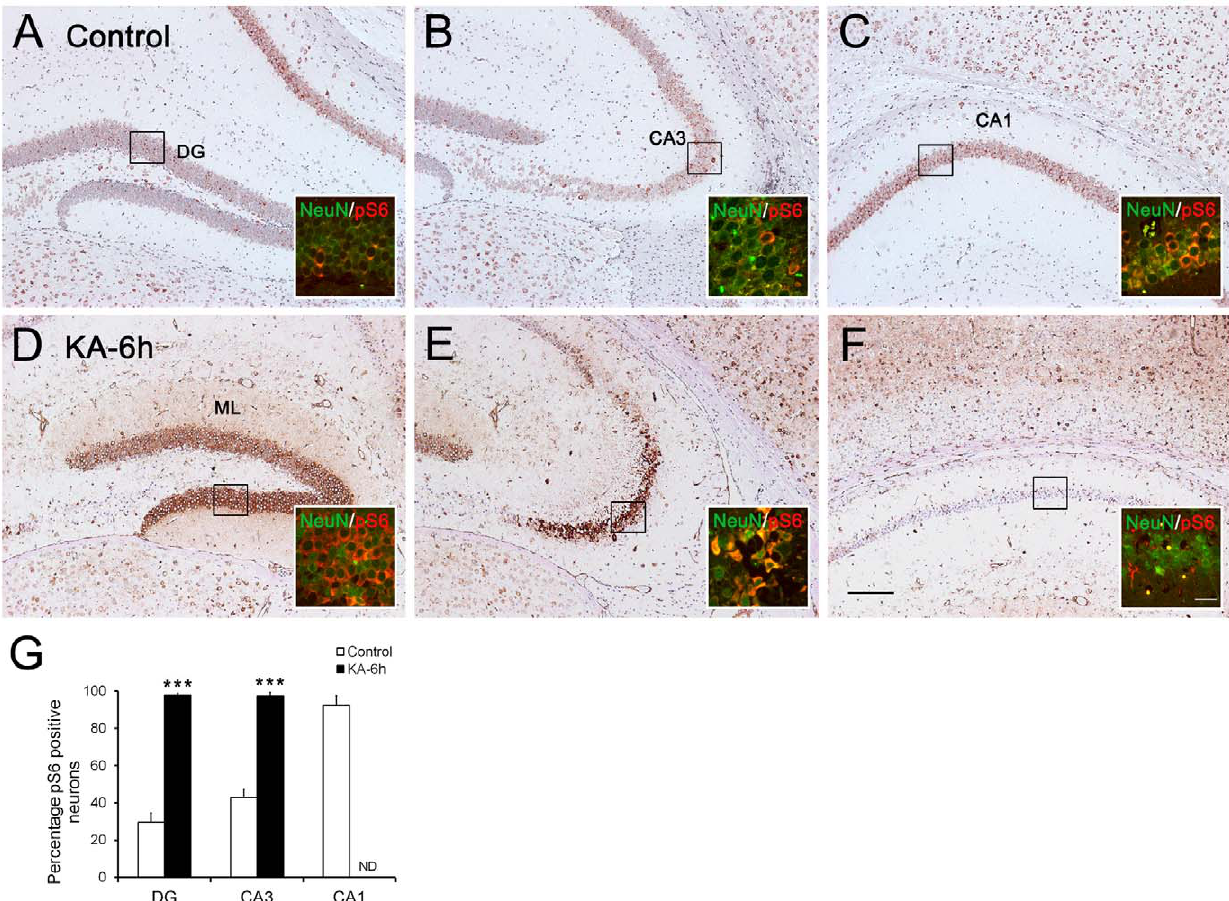
Figure 1. Distribution of pS6 immunoreactivity (IR) in the hippocampus of control mice and 6 hours after induction of seizures. (A-C) In saline-injected control mice (n=4), the density of pS6 IR varies in the different hippocampal subfields. In dentate gyrus (DG), pS6 IR is weak and only present in some of granule cells (A). In the pyramidal cell layer, pS6 IR is detectable in the entire CA3 subfield (B) and strong in the CA1 region (C). Hippocampus 6 hours post-SE (n=4) shows significantly increased pS6 IR within the dentate gyrus (D) and CA3 subfields (E) compared with control hippocampus, but pS6 IR is absent in CA1 (F). Insets in D-F show increased expression of pS6 (GFAP-positive, red) in neurons (NeuN-positive, green) of epileptic hippocampus than control hippocampus (A-C). Neuronal death is indicated by nuclear pyknosis. (G) Quantification of pS6 positive neurons in hippocampus at 6 h after seizures (n=4) versus control mice (n=4). Error bars are means 6 SD., **P , 0.01; ***P , 0.001 is based on Student’s t-test. ND, not detectable. ML: molecular layer; HS: hippocampal sclerosis; KA, kainic acid. Scale bar in A-F: 200 m m; in insets: 30 m m.